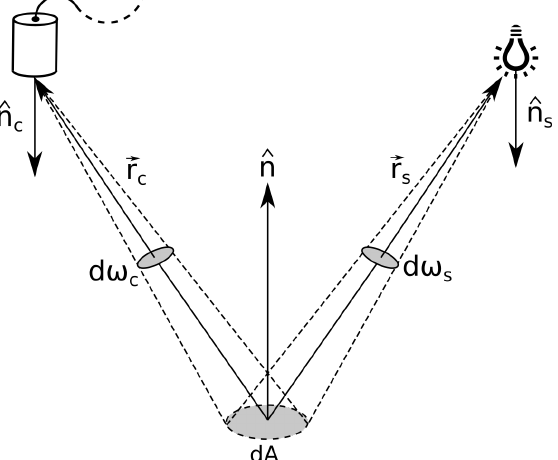
Figure 3. Illustration for underwater light propagation and imaging. The unit normal vectors of the camera, surface and light source are used to indicate their orientation. The vectors (cid:126) r c and (cid:126) r s indicate the direction and distance between the surface and camera/source, respectively. The areas d ω c , d ω s and dA denote the solid angle subtended by the camera aperture, the solid angle of the projected surface area and a differential surface area,